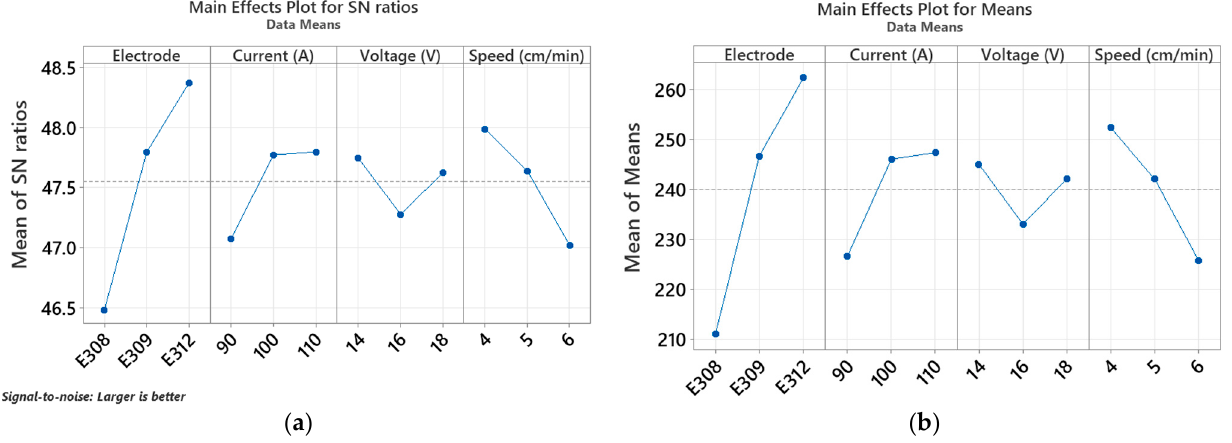
Figure 3. ( a ) S/N ratio and ( b ) mean response graphs for hardness.